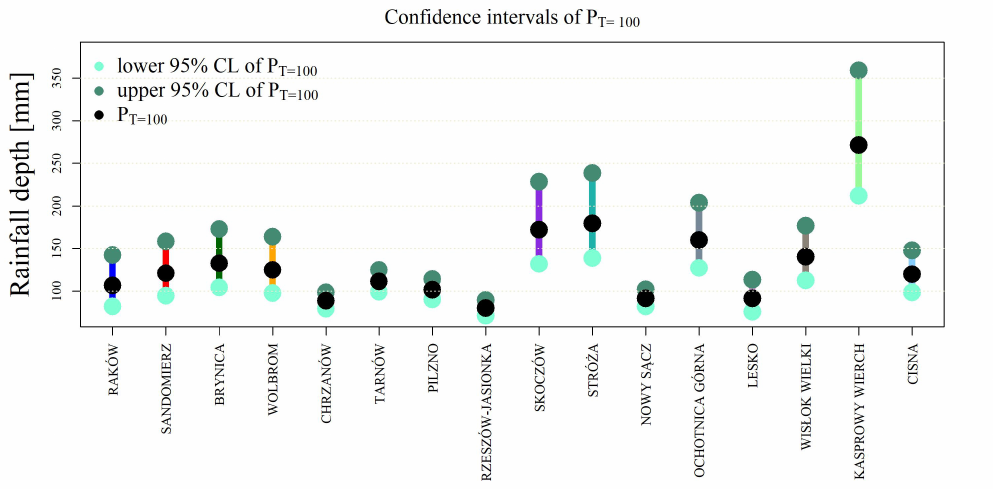
Figure 5. Confidence intervals of P T = 100 .